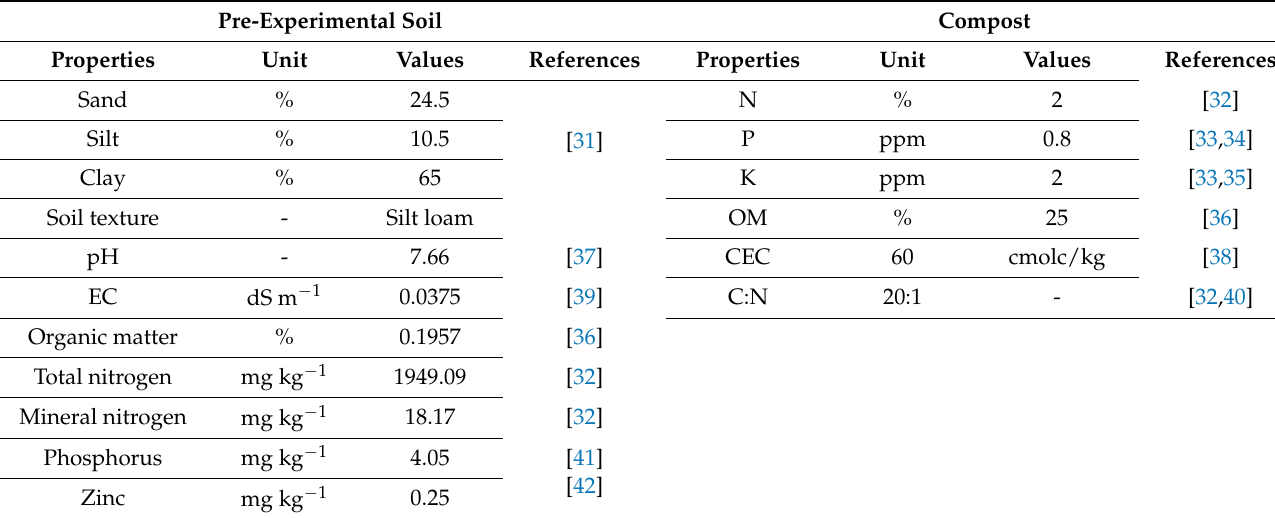
Table 2. Characterization of soil and